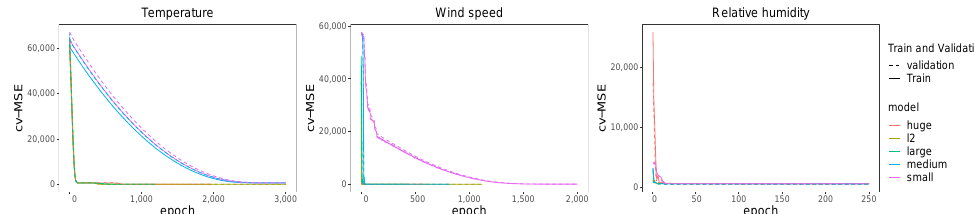
Figure 17. cv-MSE and epochs with five neural network models for temperature, wind speed, and relative humidity. Sizes of networks grow from a small model with one hidden layer to a huge model with four hidden layers. Validation errors and training errors are denoted with dashed and solid lines, respectively.